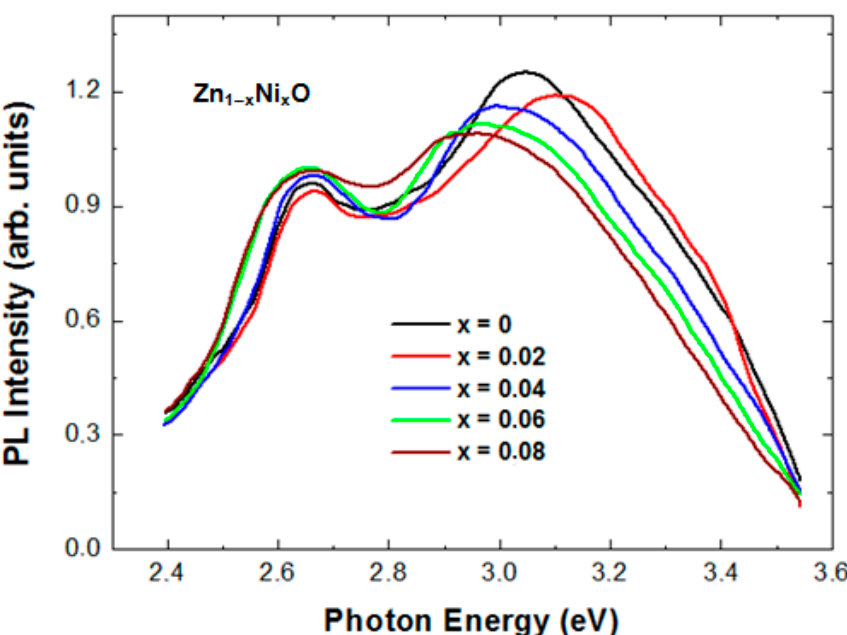
8 of 13 Figure 7. The d–d transitions of Ni 2+ ions in transmittance spectrum of Zn 0.96 Ni 0.04 O thin film. The room temperature photoluminescence spectra of the Zn 1 − x Ni x O thin films are shown in Figure 8. For all samples, an intense emission band at 380 nm is observed in the PL spectrum. This typical emission occurs in all studied films because of the near-band edge emission due to exciton-related transitions. The energy position of this band directly depends on the nickel content and is in good agreement with the results obtained from the optical absorption spectra.